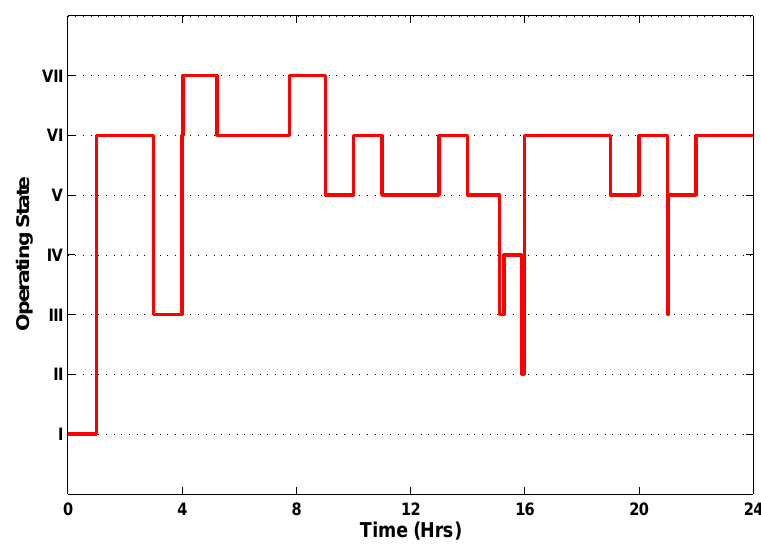
Figure 15. Operating states generated by the energy management system